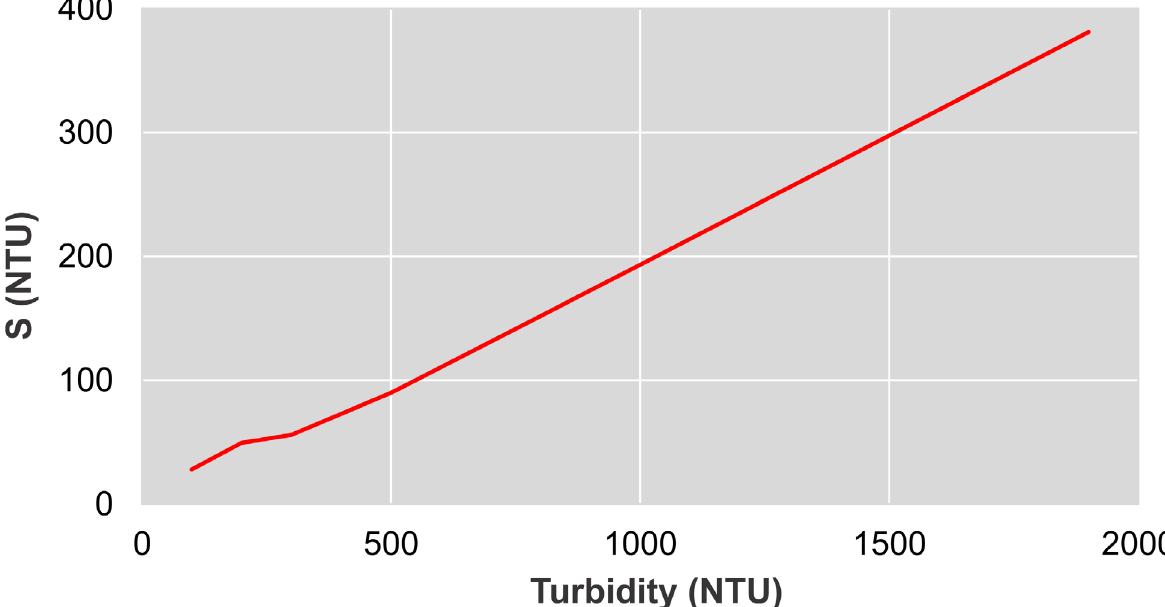
Figure 7. Computed values of S as function of field measured turbidity, showing that the error linearly increases as the turbidity